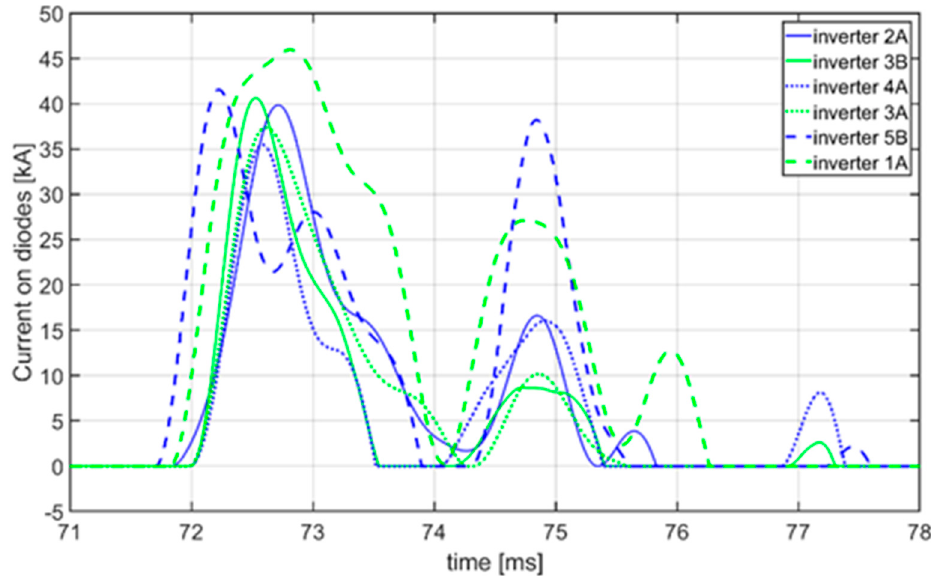
Energies 2021 , 14 , x FOR PEER REVIEW 10 of 19 Figure 8. Current in diodes of healthy modules with the setup foreseeing a partial installation of dc/ac modules.